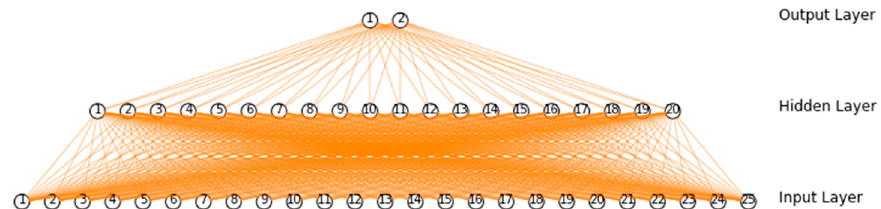
Figure 4. Structure of the proposed multi-layer perceptron algorithm.